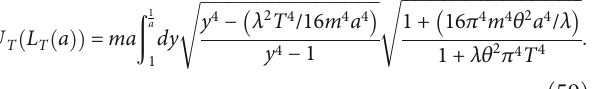
ffiffiffiffiffiffiffiffiffiffiffiffiffiffiffiffiffi